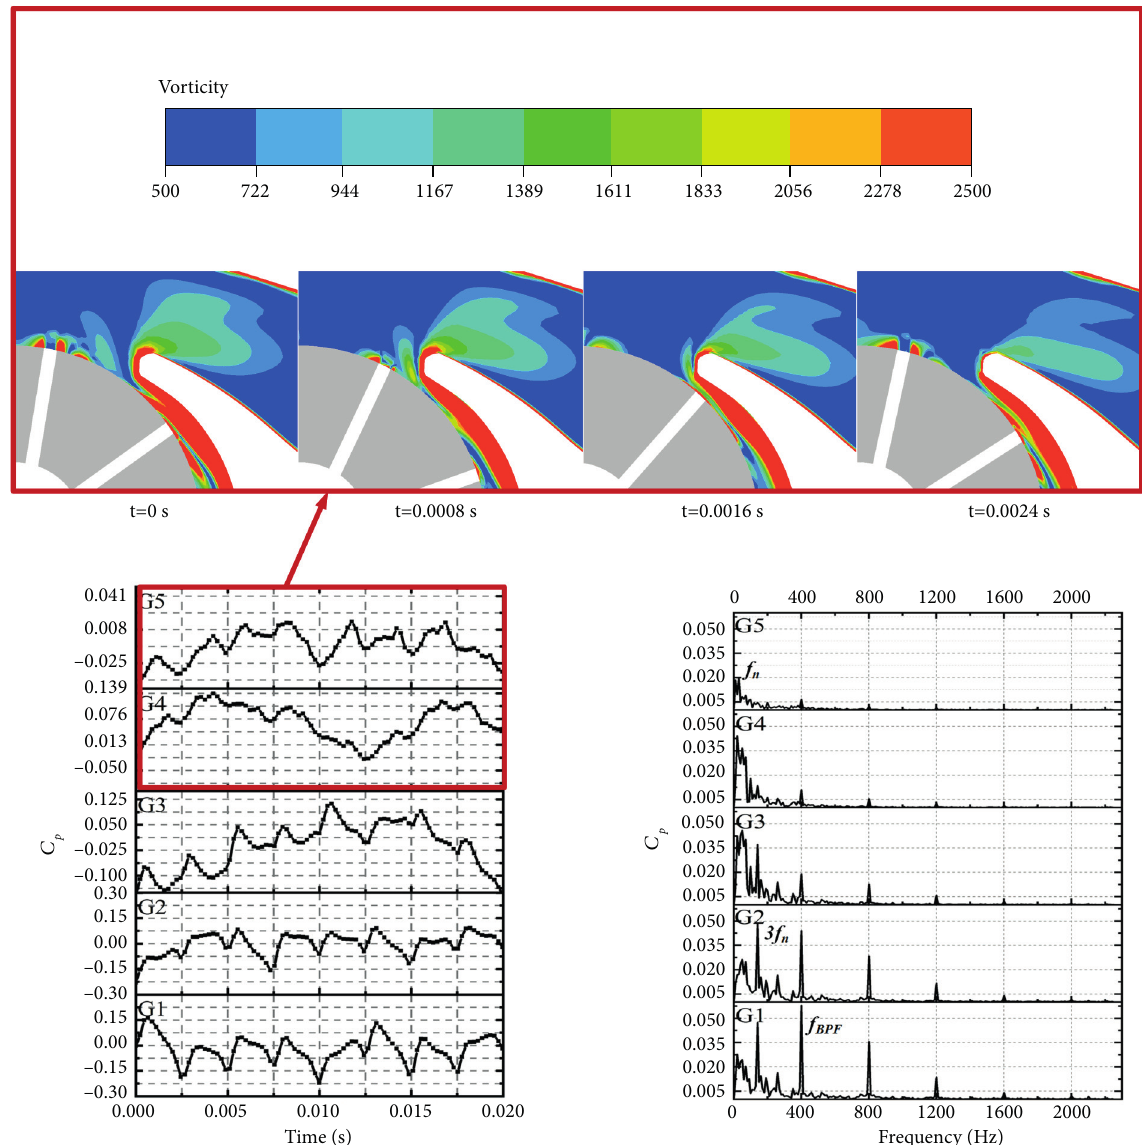
Figure 12: Time and frequency domains of the pressure pulsation at monitoring points